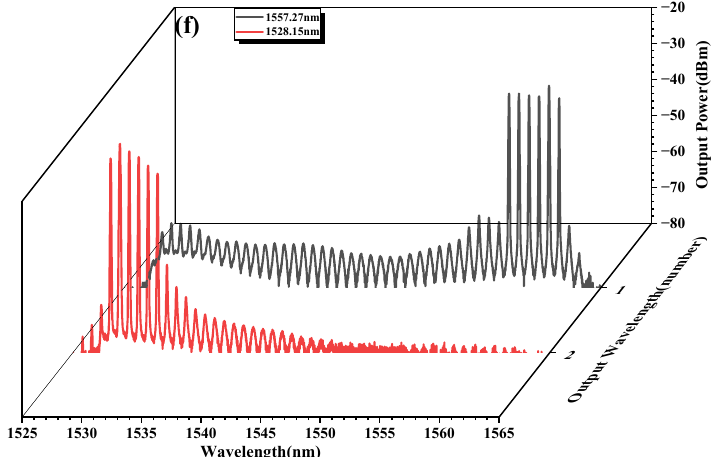
Figure 7. Output spectra of tunable ( a ) single-, ( b ) dual-, ( c ) triple-, ( d ) quad-, ( e ) quintuple-, and ( f ) sextuple-wavelength.